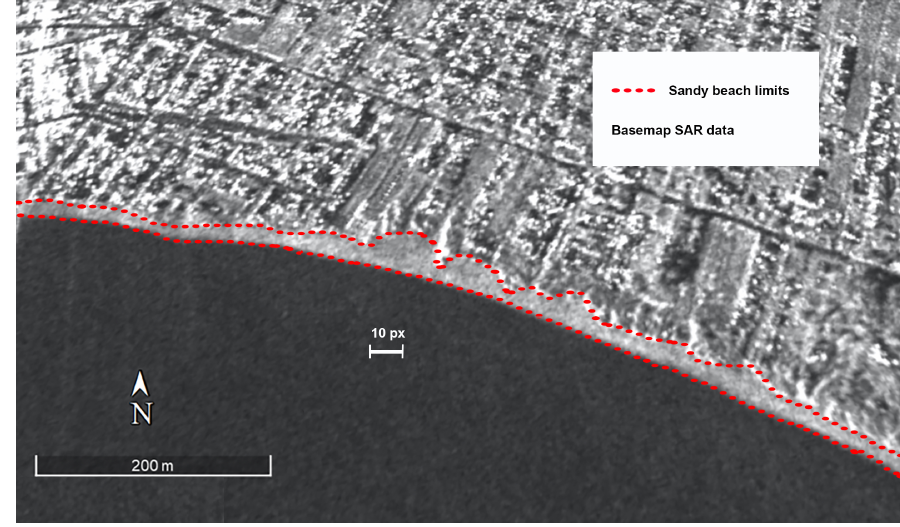
Figure 6. Synthetic Aperture Radar (SAR) Pixels belonging to sandy beach